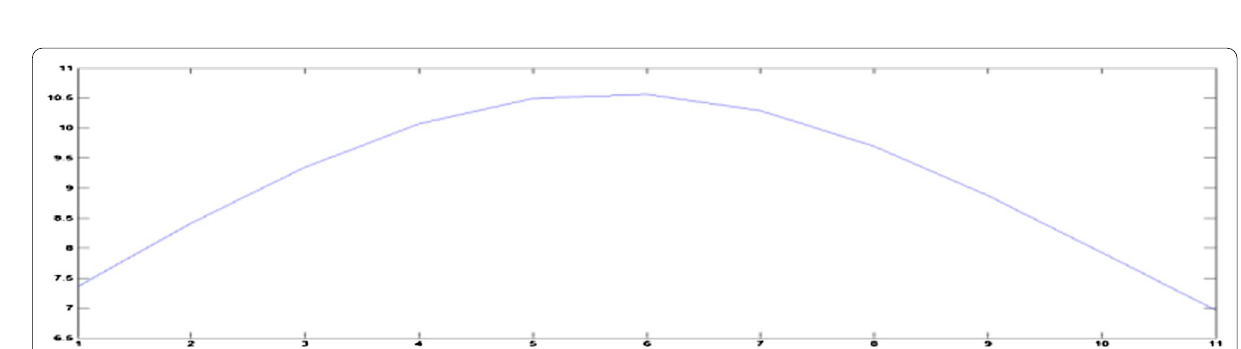
Fig. 13 Percentage leakage around the peak: the figure shows the percentage leakage at each point around the peak. Percentage of time spent at the mean rate should be more than time percentage spent at the heart rate lies around peak